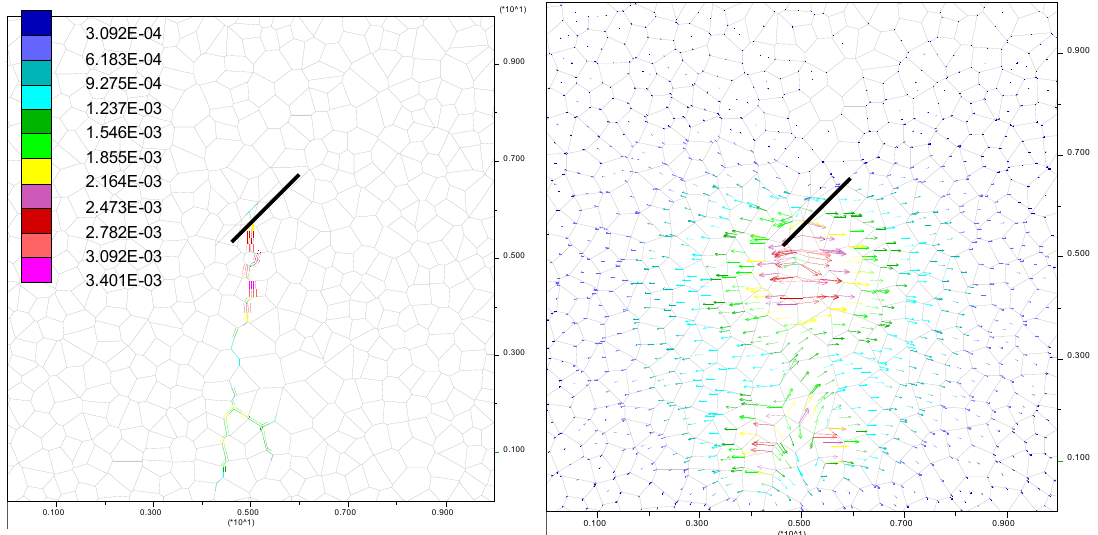
Figure 5. Arresting mode in numerical modeling with an incidence angle of 45 degrees under differential stresses of 10 MPa